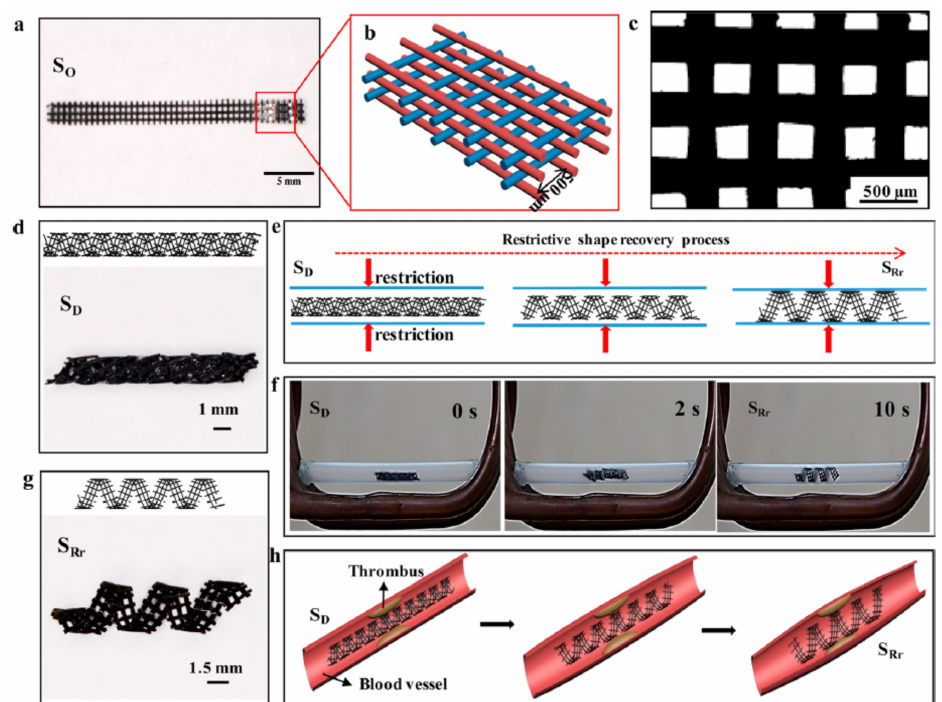
Figure 9. 4D scaffold of c-PLA/Fe3O4 ink and its potential biomedical application. ( a ) Optical image of the multilayer scaffold; ( b ) schematic diagram of the detailed structure of the scaffold; ( c ) top view of the optical image of the printed scaffold; ( d ) deformation shape of the printed scaffold; ( e ) schematic of the restrictive shape recovery process; ( f ) demonstration of the restrictive shape recovery process triggered by a 30 kHz alternating magnetic field; ( g ) recovery shape under restrictive conditions; ( h ) potential application of the 4D scaffold as an intravascular stent. Reprinted with permission from Ref. [253]. Copyright 2017, American Chemical